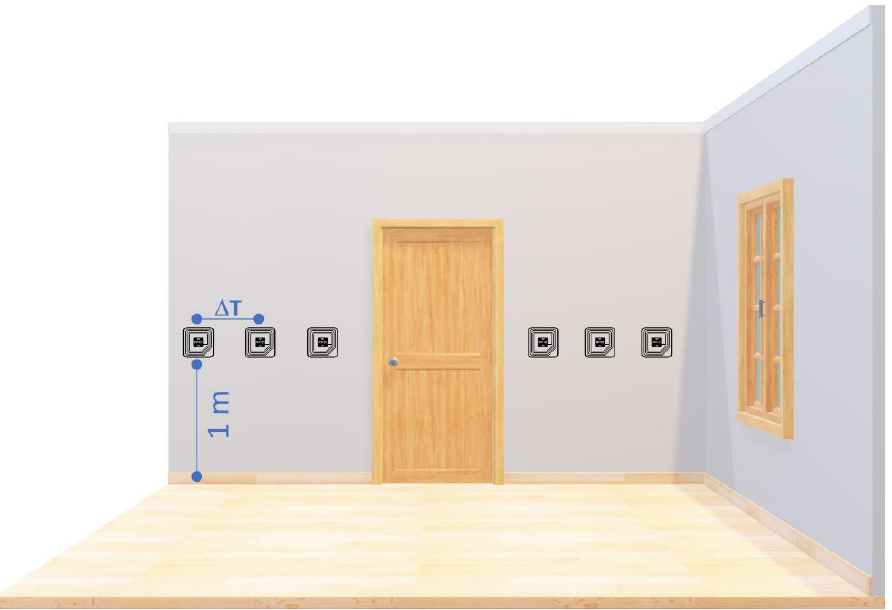
Figure 10. A schematization of the scenario adopted for the sake of the second assessment.